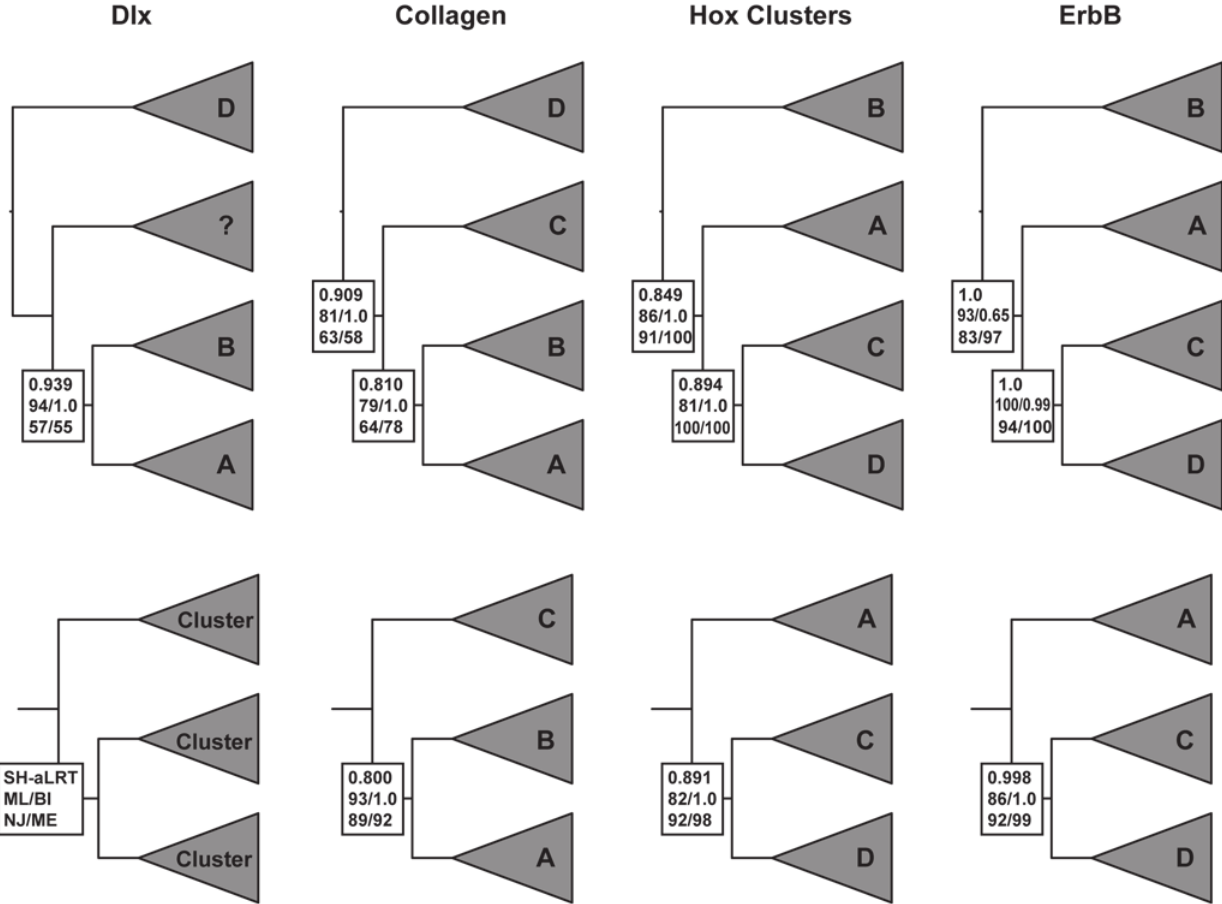
Figure 2. Gene trees for the ‘‘core’’ Hox paralogon. Gene names are shown with respect to which Hox cluster they are linked to, for example Col3A1 is linked to the HoxD cluster and is shown as ‘‘D’’ while Col1A2 is linked to HoxA is and shown as ‘‘A’’ (see Figure 1). Branch support values are shown for internal branches with the SH-like approximate likelihood ratio test results shown upper (HS-aLRT), maximum likelihood(ML)/Bayesian inference(BI) shown middle, and neighbor-joining(NJ)/minimum evolution(ME) shown lower (see inset). Full taxon trees are shown in the upper row, while the lower row shows the topology and branch support values when the most basal gene cluster excluded and trees re-inferred.